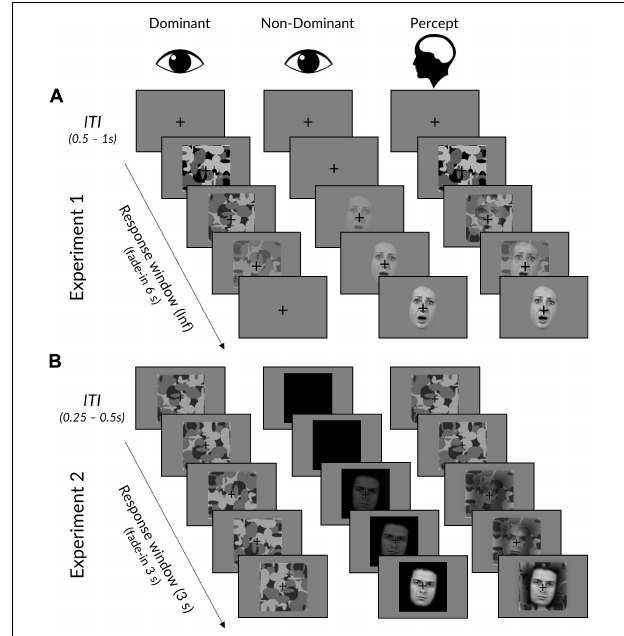
FIGURE 1 | Interocular suppression paradigm for Experiments 1 and 2. (A) In Experiment 1, face stimuli linearly increased from 0 to 100% contrast over 6 s in the dominant eye, while the mask did the opposite in the dominant eye. Trials ended upon response, followed by an ITI displaying a fixation cross. (B) Experiment 2 was the same, except that: (i) face stimuli linearly increased over a period of 3 s to a titrated subject-specific maximum contrast, (ii) masks remained at maximum contrast, (iii) face background was black rather than grey, (iv) trials ended after 3 s regardless of whether a response had been made, and (v) masks remained throughout the ITI. The “Percept” column illustrates a typical subjective experience, in which initially only a mask could be perceived, followed by a mixed perception of both mask and face. Facial stimuli reproduced with permission from the Warsaw Set of Emotional Facial Expression Pictures (WSEFEP), available at